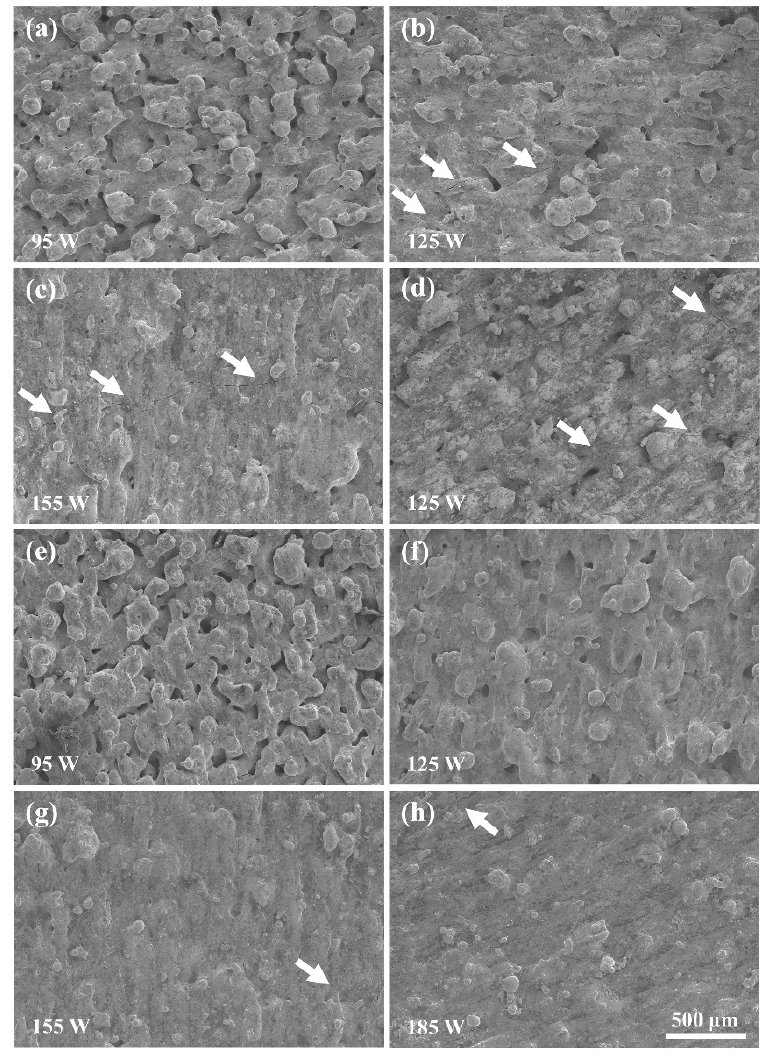
Figure 10. The SEM morphologies of the bulk surface: ( a – c ) bulks formed on the 316L substrates; ( d ) bulk formed on the YG15 substrate; ( e – h ) bulks formed on the Ni200 substrate.